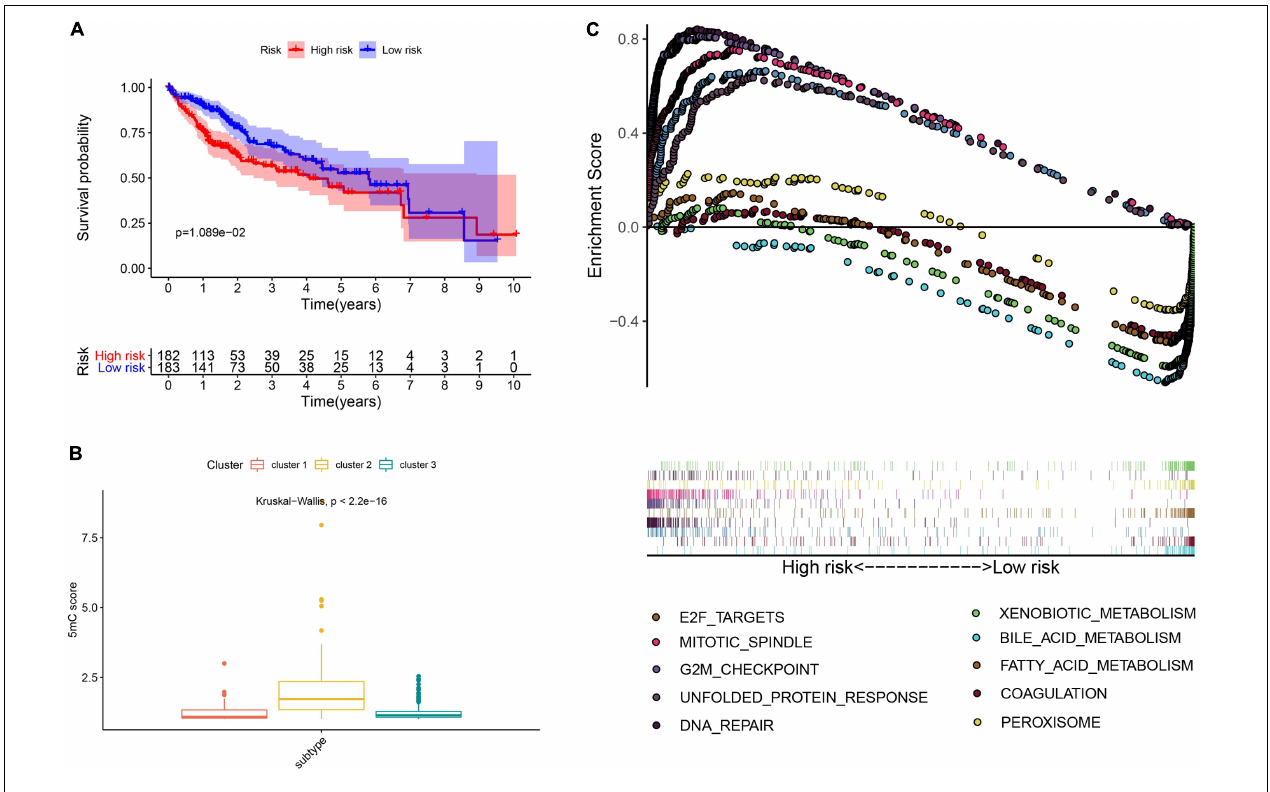
FIGURE 7 | Exploration and validation of the 5mC score. Panel (A) shows the results of survival analysis, (B) shows the correlation analysis between 5mC score and subtypes, and (C) shows the result of gene set enrichment analysis.